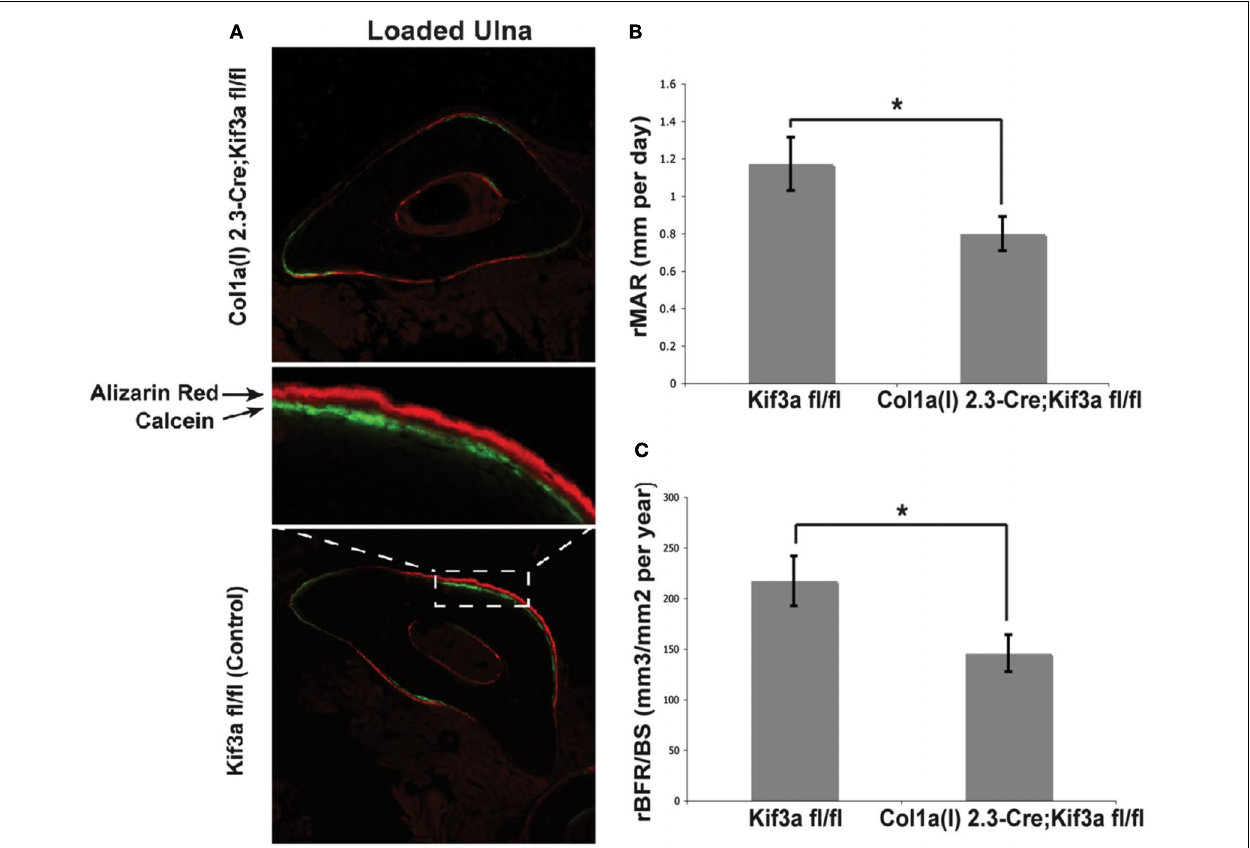
FIGURE 4 | (A) Representative images of loaded ulnae of Col α 1(I) 2.3-Cre;Kif3a fl/fl (top) and control (bottom) mice. (B,C) Relative mineral apposition rate (rMAR, μ m per day), and bone formation rate (rBFR/BS, μ m 3 / μ m 2 per year), of mechanically loaded mice. Adapted fromTemiyasathit et al.